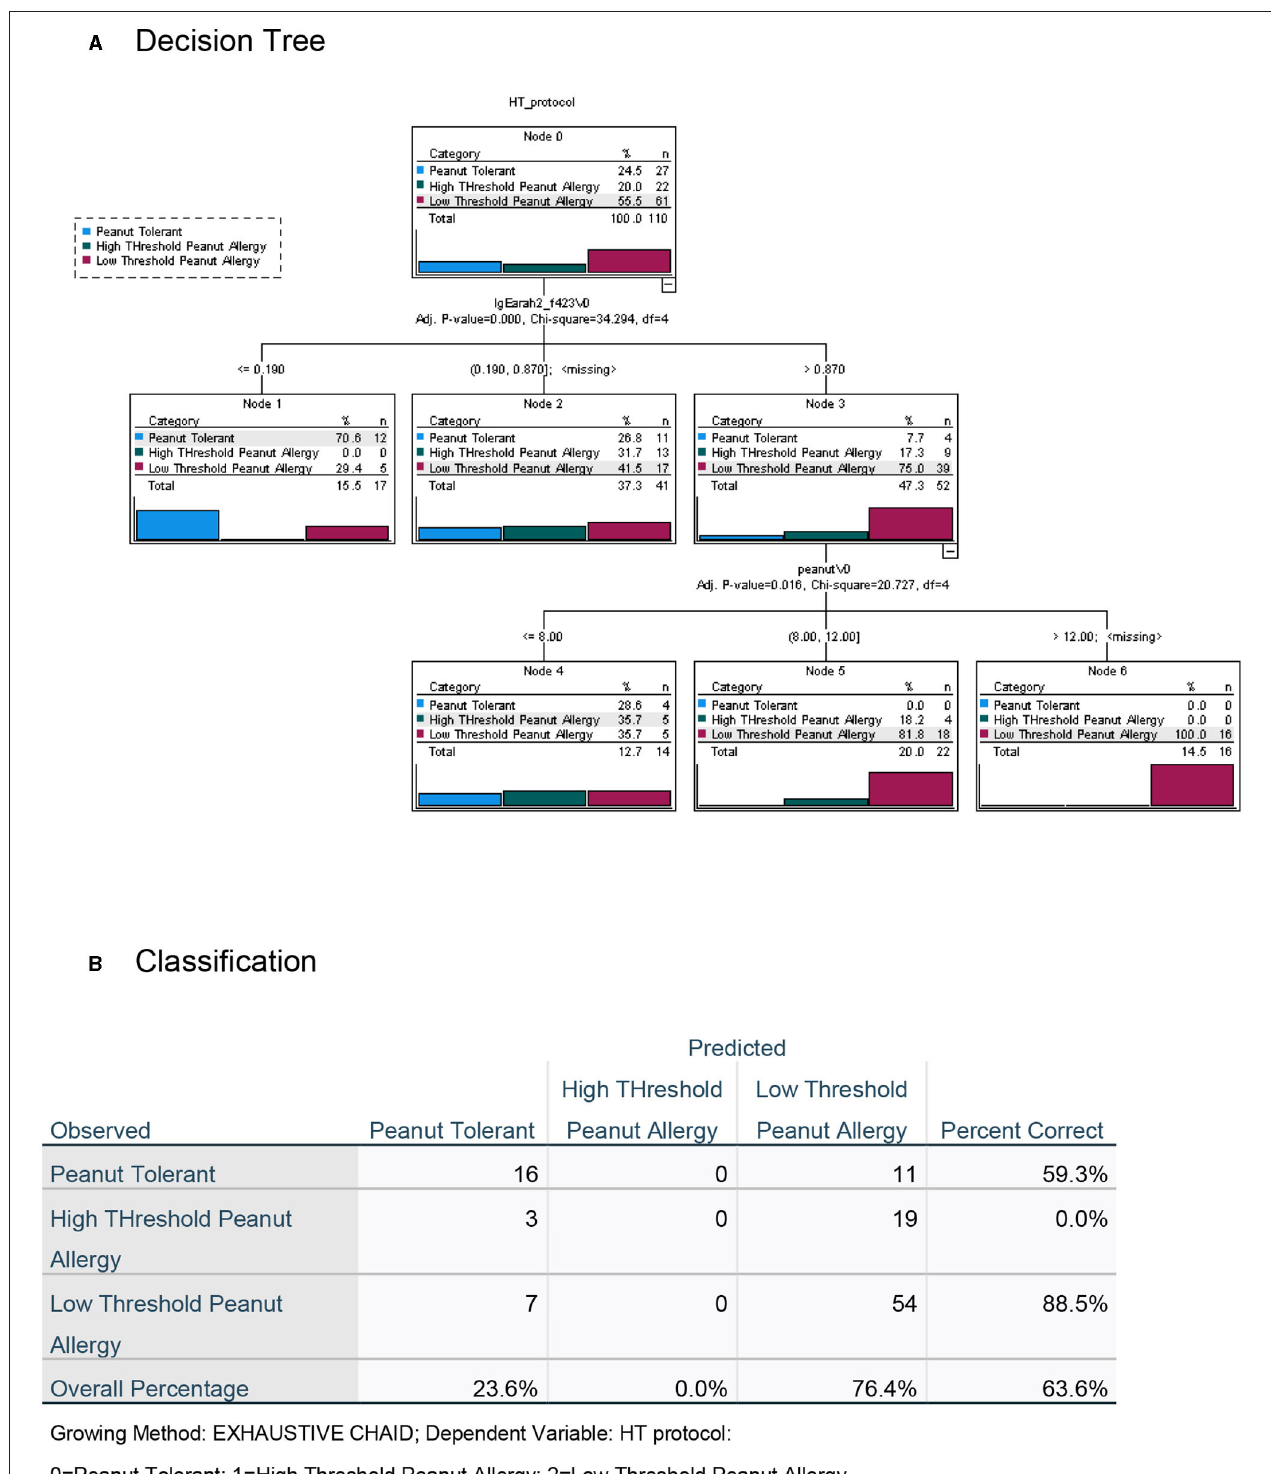
FIGURE 7 | Decision tree analysis for the classification of children with peanut tolerance and peanut allergy, with high ( > 300mg) or low ( < 300mg) threshold, excluding the data from the LPP-MH skin tests. (A) Decision tree and (B) Classification table.